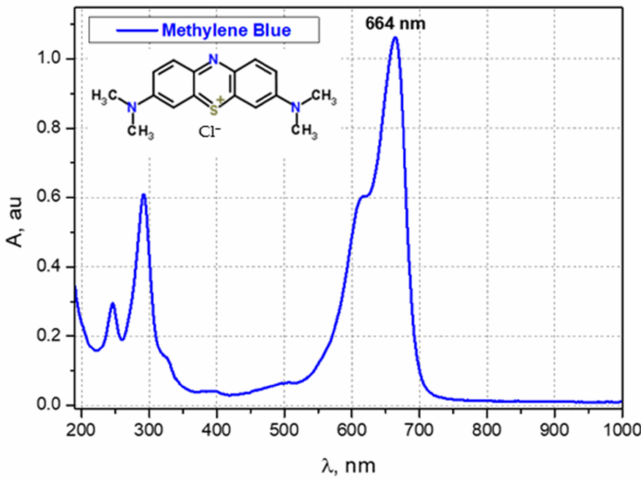
Figure 5. Absorbance spectrum of the MB solution (16 ppm).